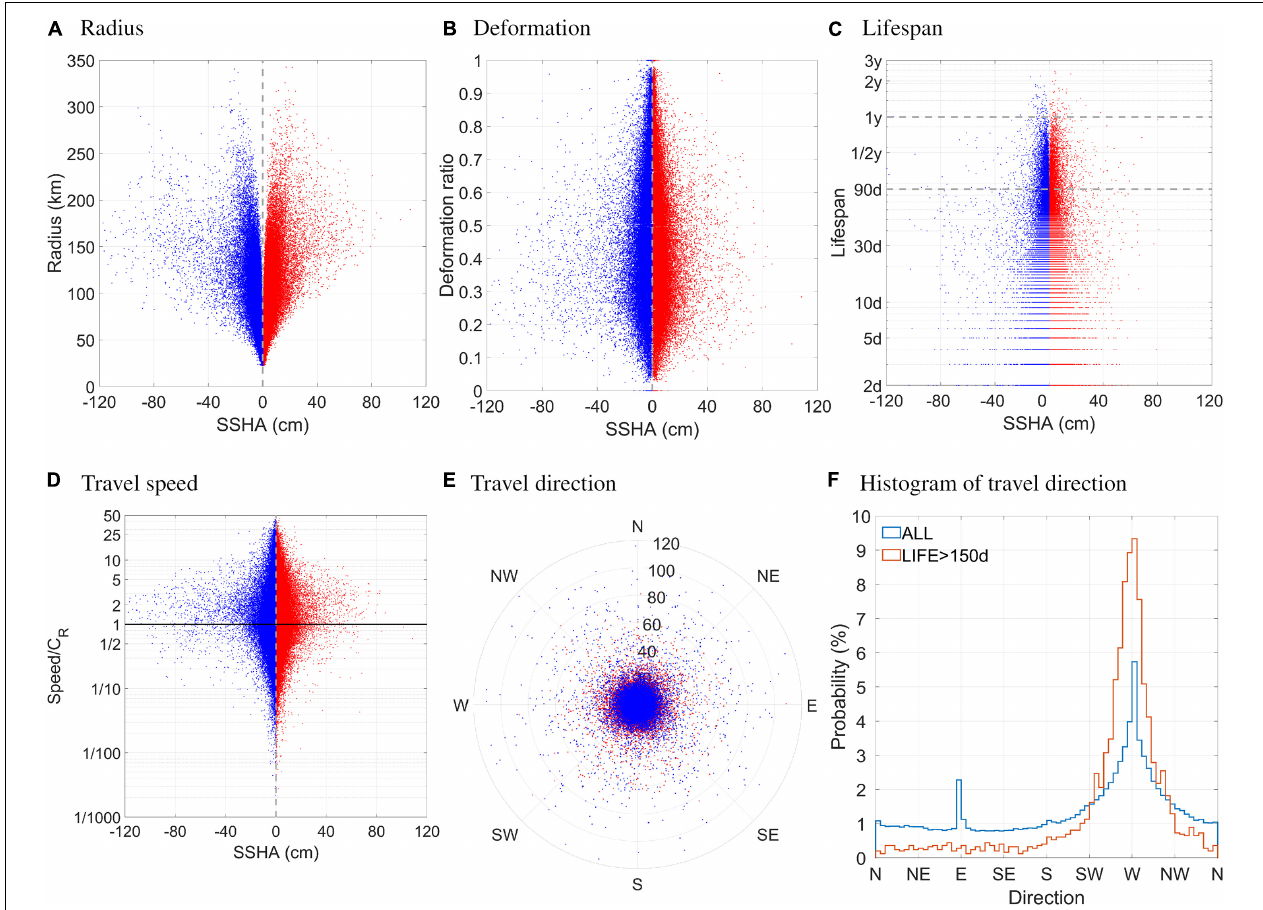
FIGURE 2 | Scatter plots showing the statistical relationship between eddy amplitude (cm) and (A) radius (km), (B) deformation ratio, (C) lifespan (days; note the logarithmic y -axis; amplitude is taken at the eddies’ half-life), (D) the ratio between travel speed defined as the track length divided by the lifespan and the theoretical speed of long baroclinic Rossby wave (note the logarithmic y -axis), and (E) travel direction defined as the azimuth of eddy termination location relative to the generation location. Red (blue) dots represent anticyclonic (cyclonic) eddies. The radial axis indicates eddy amplitude in cm. (F) Histogram of eddy travel direction. Red stairs represent the histogram over all eddies, and blue stars are for eddies persisting for longer than 150 days.